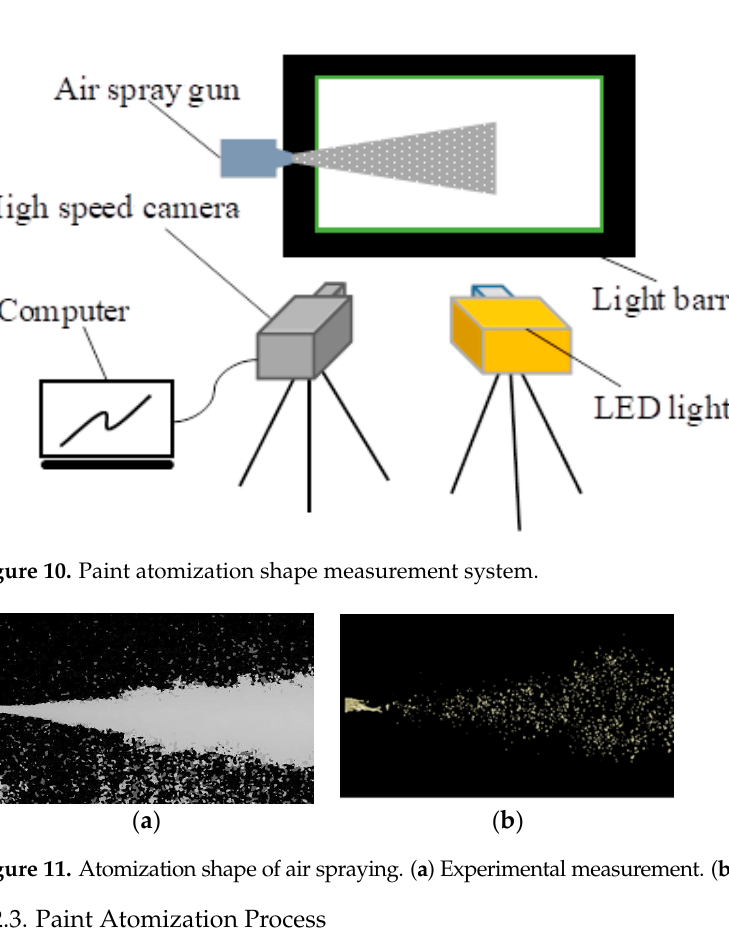
( b ) Figure 9. Comparison of paint film thickness. ( a ) Paint film thickness distribution along the long axis. ( b ) Paint film thickness distribution along the short axis. As is seen from Figure 9, the experimental spraying results of the coating thickness distribution of the plane were consistent with the numerical simulation results in general. However, some errors still appeared as follows: at both sides, the experimental coating thickness was larger than the numerical simulation results, whereas the middle parts showed the opposite trend, which was mainly caused by the leveling property of the liq- uid paint. 4.2.2. Comparison of Paint Atomization Shape A high-speed camera was used to capture the shape of the spray flow field, and the measurement system for the paint atomization shape is displayed in Figure 10. The con- ditions of the atomization experiment and numerical simulation were consistent, and the atomization shapes obtained by measurement and numerical simulation are shown in